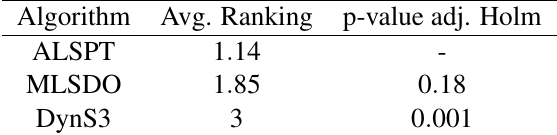
Table 12. Average rankings provided by the Friedman’s non- parametric test for ALSPT, MLSDO and DynS3 considering the results over 7 MPB configurations ( s = { 1 , 2 , 3 , 4 , 5 , 6 } ; n = { 100 } ), and adjusted p-value according to the Holm’s post- hoc procedure using ALSPT as control